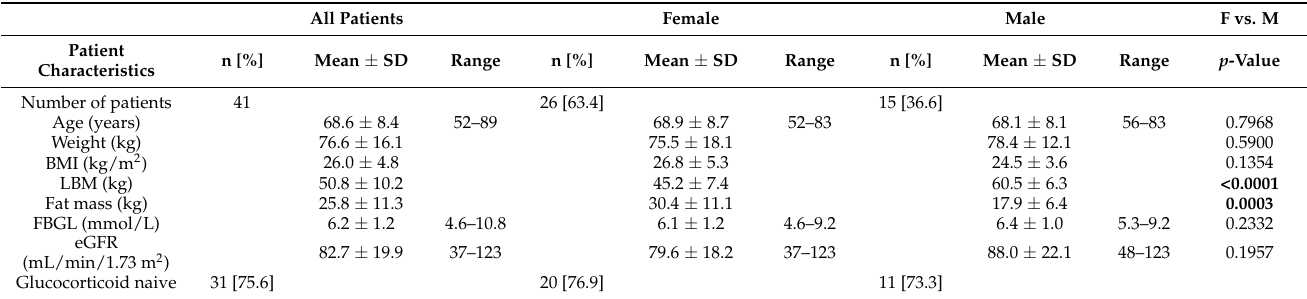
Table 1. Patient characteristics of all patients together and female and male separately. Statistically significant p -values from comparisons between females and males are highlighted in bold.